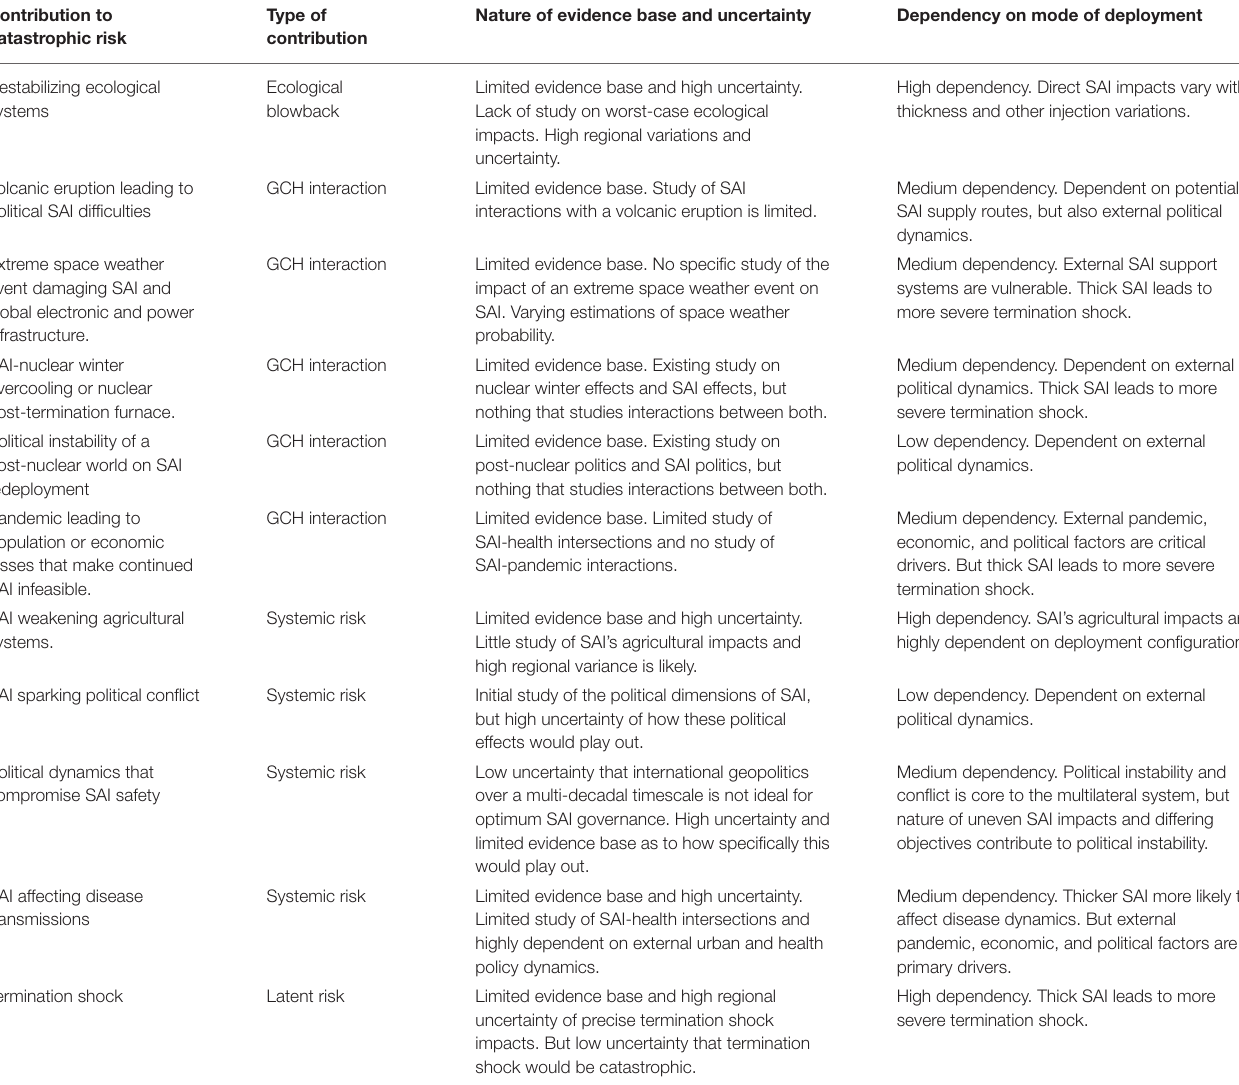
TABLE 2 | Summary of SAI’s direct impacts, GCH interactions, systemic risks, and latent